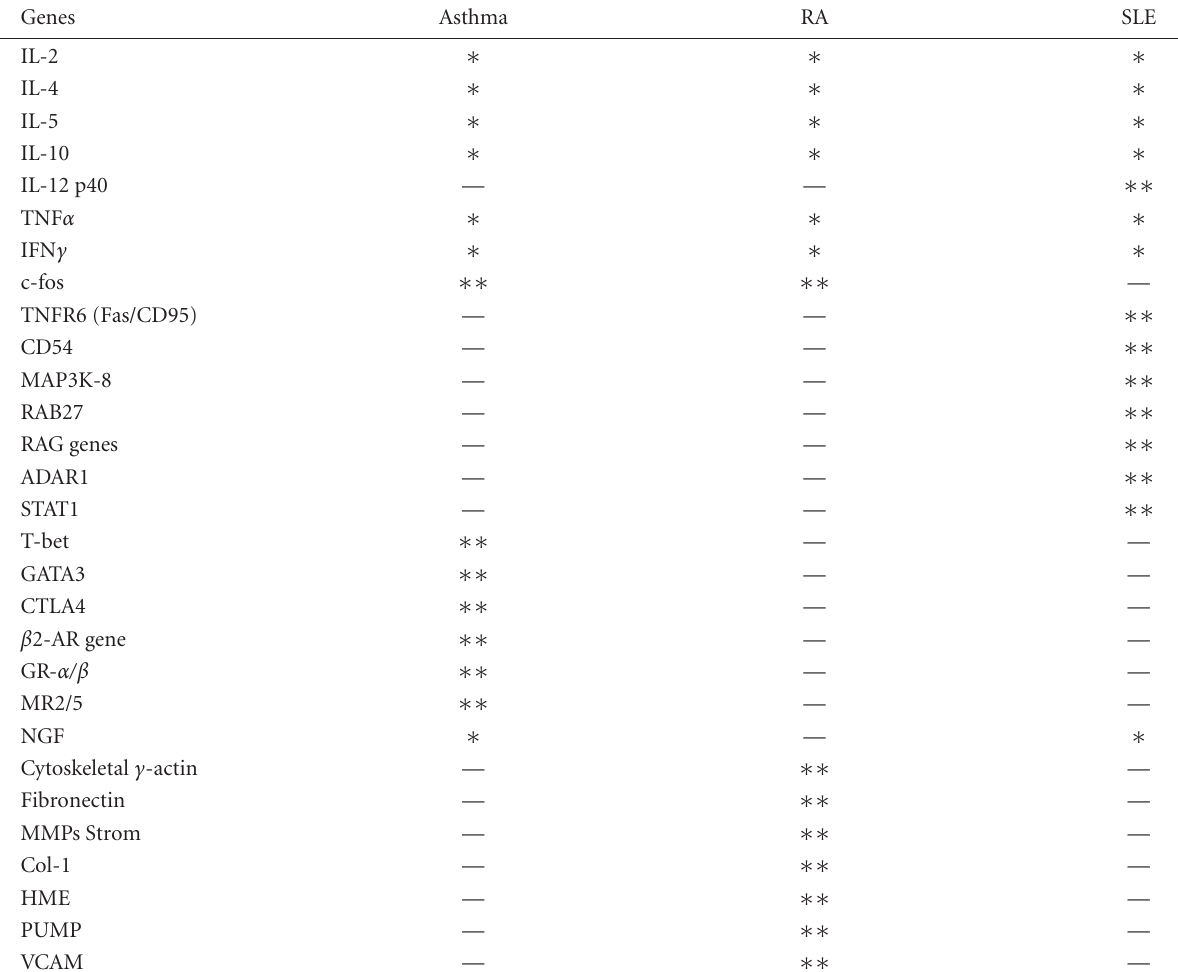
Table 1. Examples of general gene-expression profiles and disease-specific profiles in asthma, RA, and SLE. ( ∗ nonspecific gene expression, ∗∗ disease-specific gene expression, — no information.)